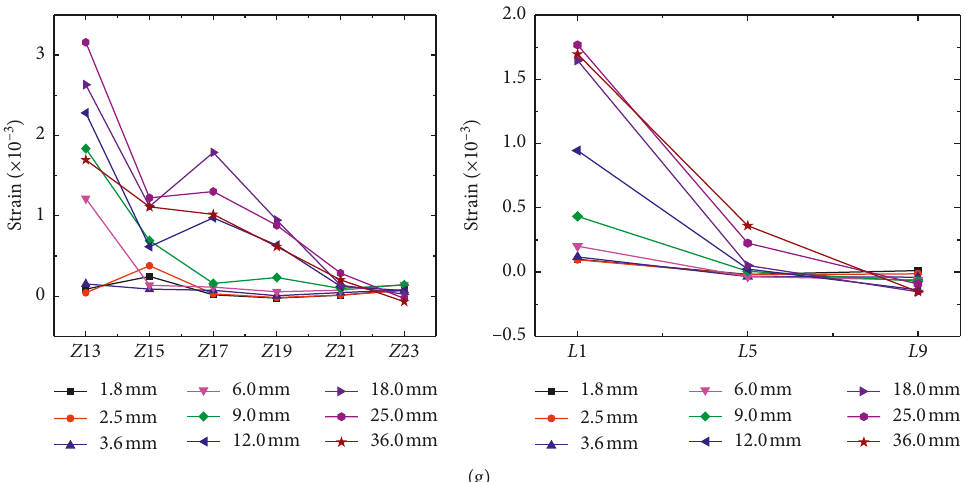
Figure 19: Steel strain curve. (a) Specimen KJ1. (b) Specimen KJ2. (c) Specimen KJ3. (d) Specimen ZHQ1. (e) Specimen ZHQ2. (f) Specimen ZHQ3. (g) Specimen